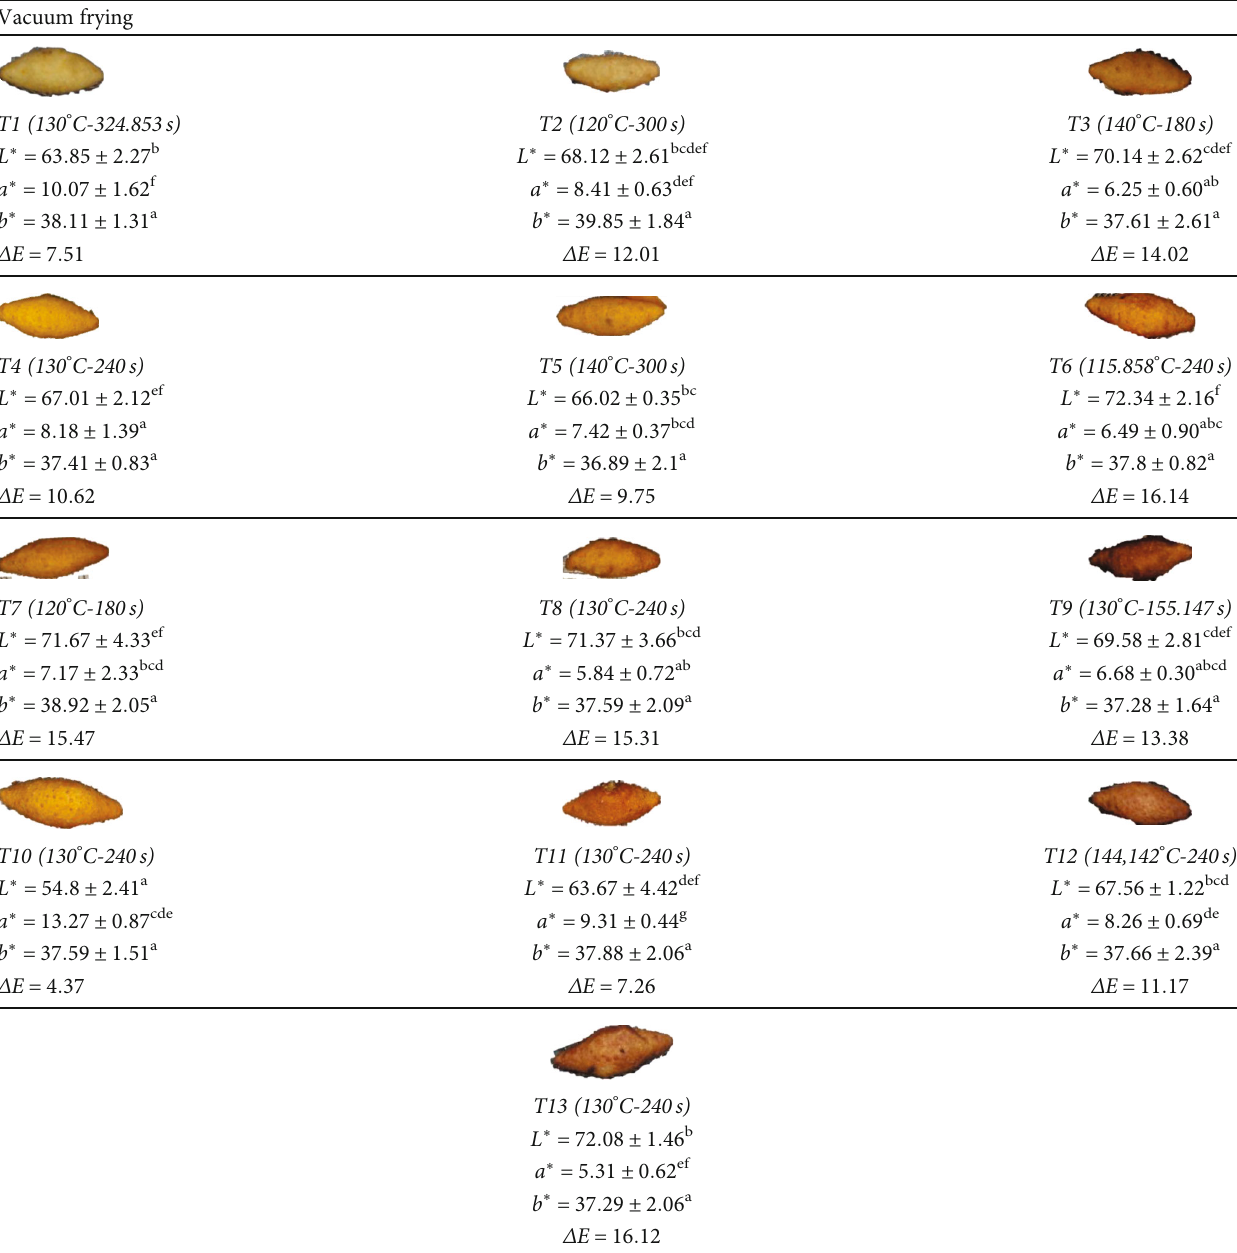
Table 4: Colour changes of the Carimañolas as a function of time and temperature. Vacuum